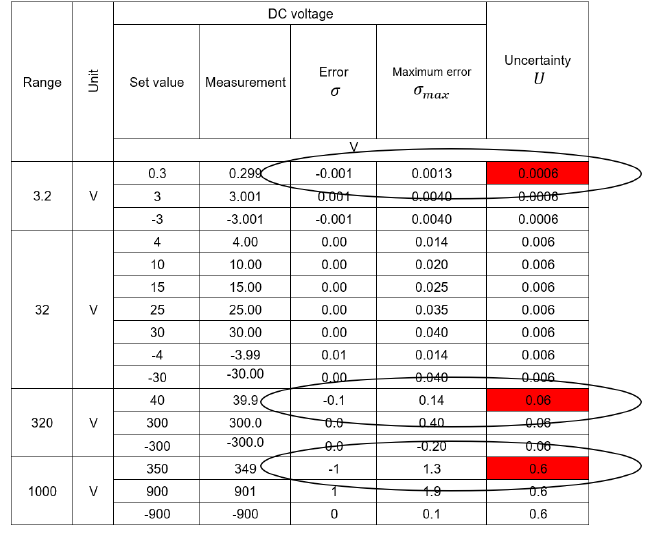
Figure 11. Manual calibration result for the point 40 V